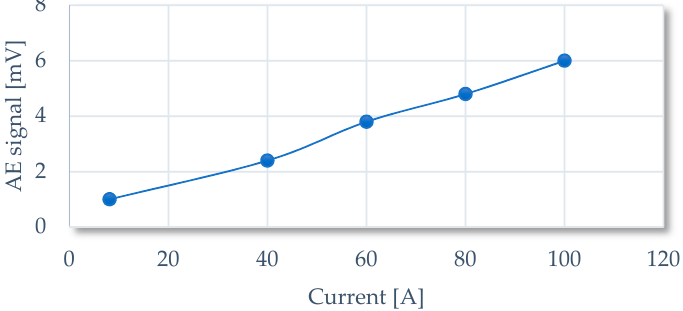
Figure 10. Graph showing the emission signal magnitude dependence as a function of the current flowing through GTO.